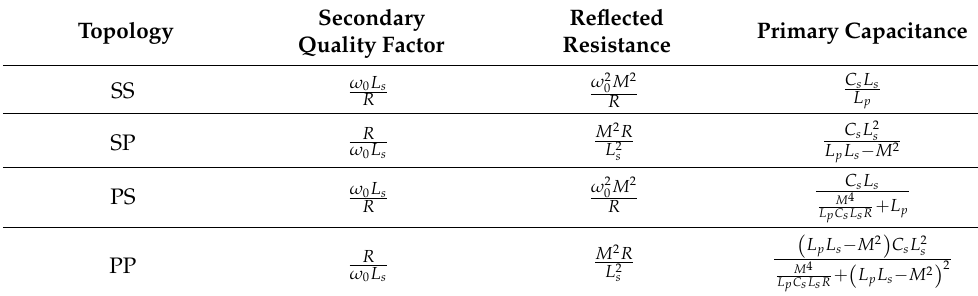
Table 3. Relationships governing the above circuit [44].